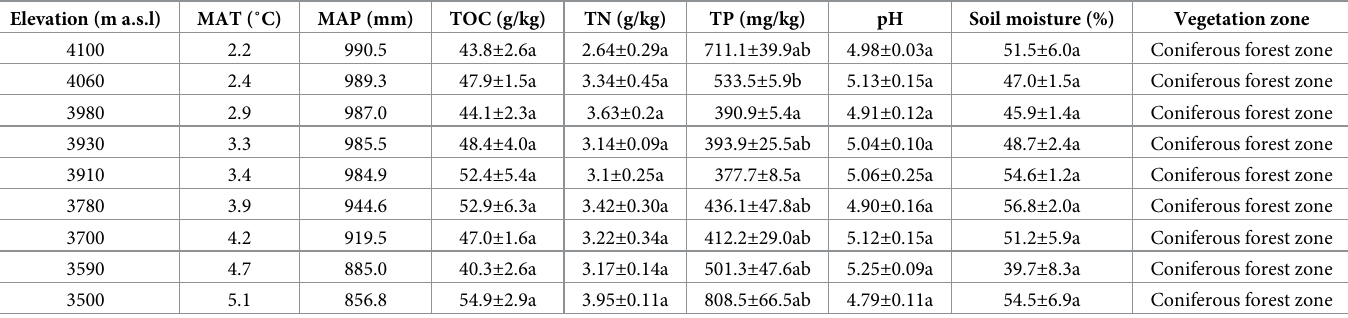
Table 1. Soil properties and climatic factors in this study area. Elevation (m